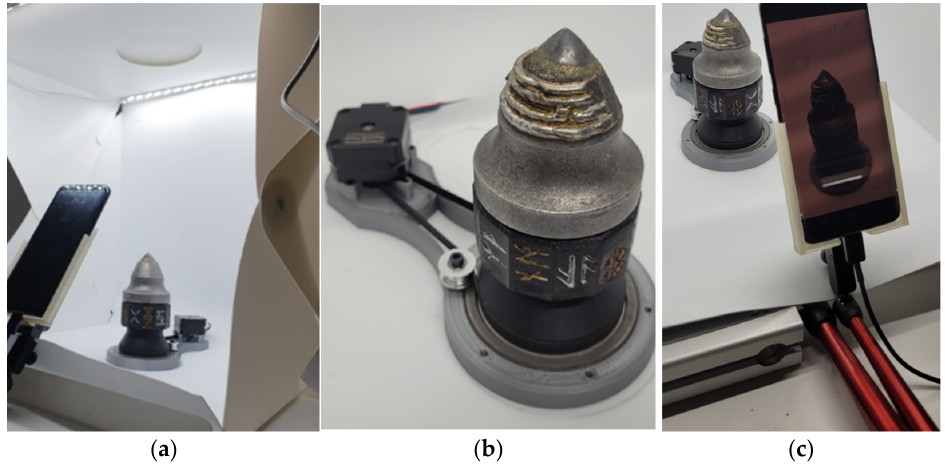
Figure 3. Image of all inspected conical pick specimens. The authors annotated them in the fol- lowing manner: ( a )—CP0 (master model), ( b )—CP1, ( c )—CP2, ( d )—CP3, ( e )—CP4.